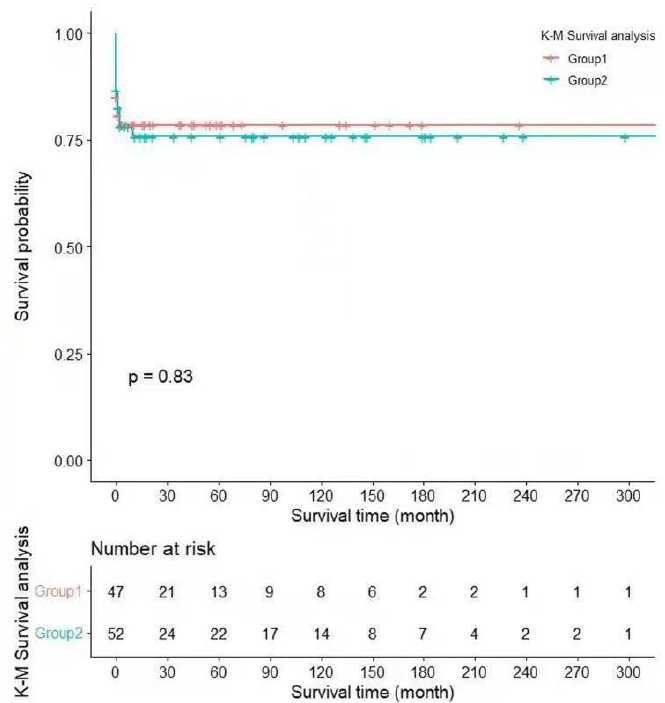
Figure 1. Comparison of the mortality between CM patients with and without underlying conditions. Group 1: Patients without underlying conditions; Group 2: Patients without underlying